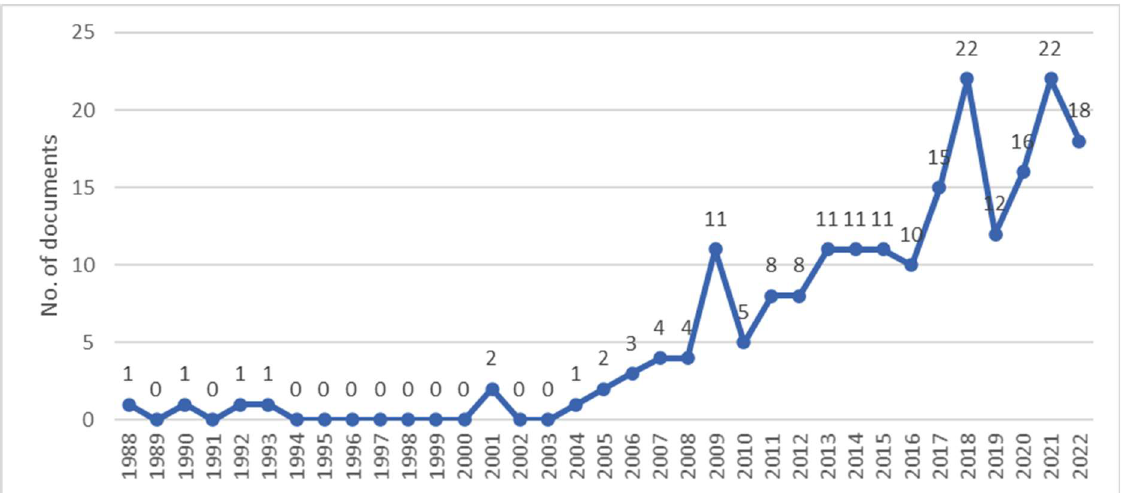
Figure 2. Annual scientific production. Source: created by the authors. The ten main journals connected to the search field performed with the Scopus data- base are shown in Table 2. All journals belong to the “Renewable Energy, Sustainability and the Environment” subject area. Most articles can be found in Q1 and Q2 categories in Elsevier and MDPI journals. These two publishers attach importance to renewable energy with its application to agricultural farms. Despite smaller SJR and H-index, Energies and Sustainability can be regarded as attractive target journals in this special field. Table 2. List of the most relevant journals.